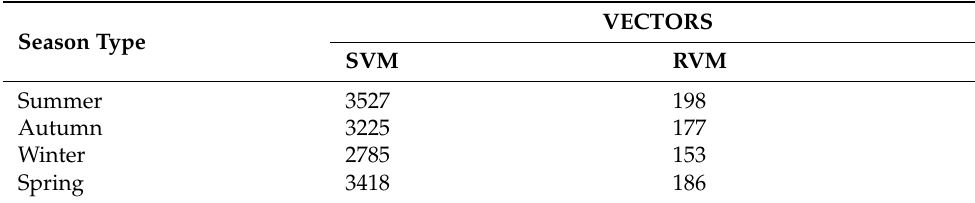
Table 7. Numbers of CV of RVM and SV of SVM.